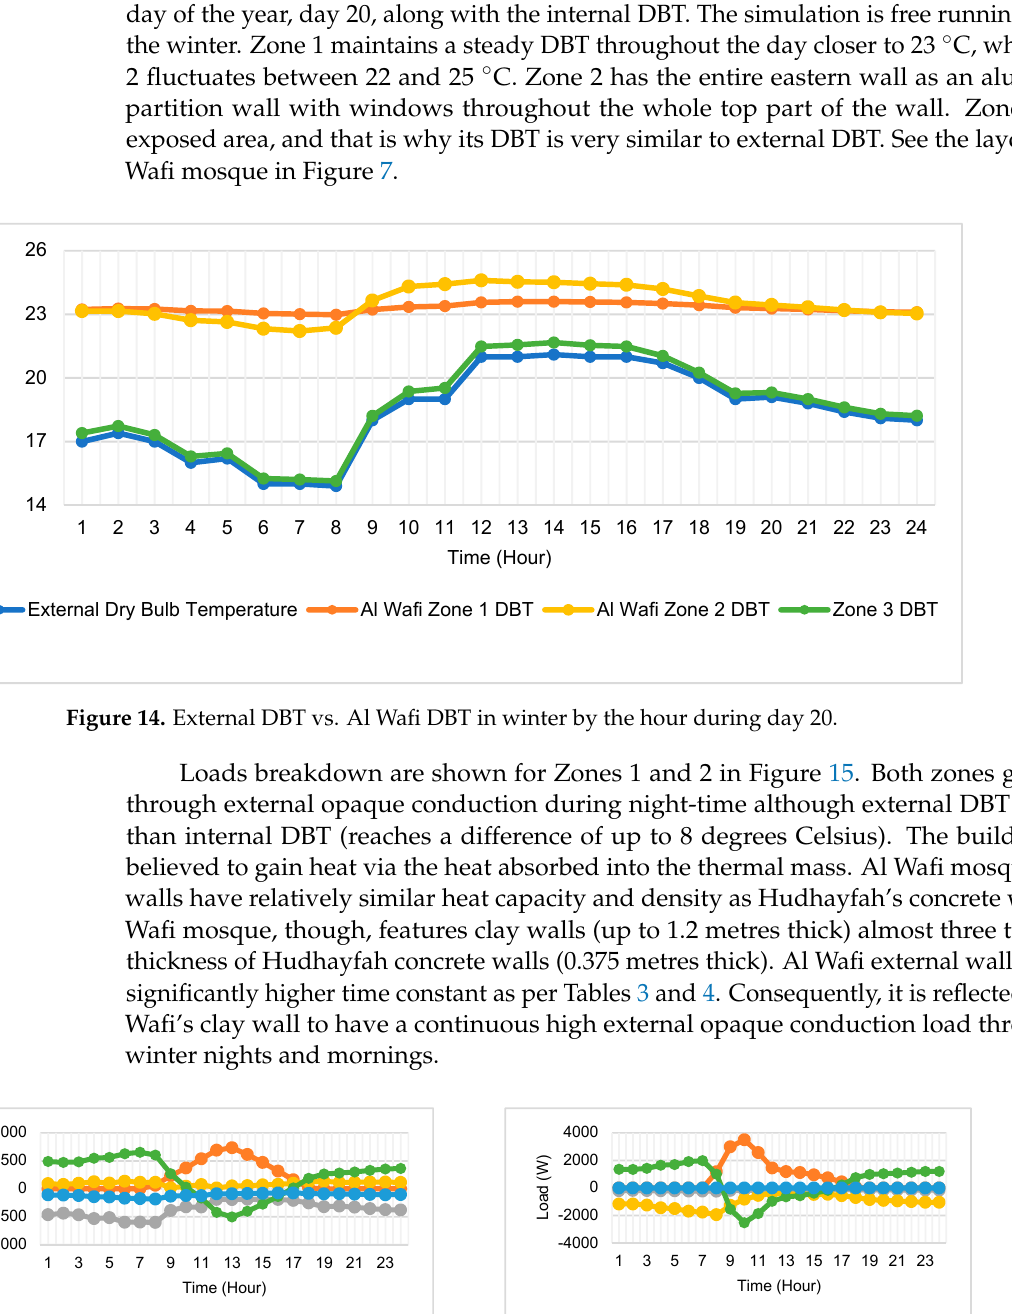
Figure 13. ( a ) Loads breakdown in Hudhayfah mosque (Zone 1) during day 179 (summer); ( b ) loads breakdown in Hudhayfah mosque (Zone 2) during day 179 (summer).